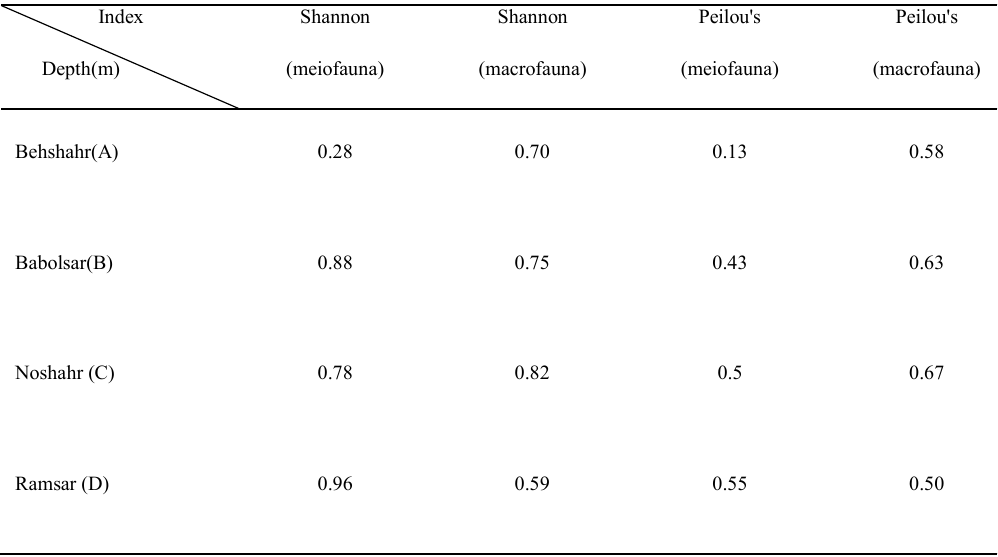
Table 7: Shnanon and Peiole index for meiofauna and macrofauna in different stations in the southern Caspian Sea from Behshahr to